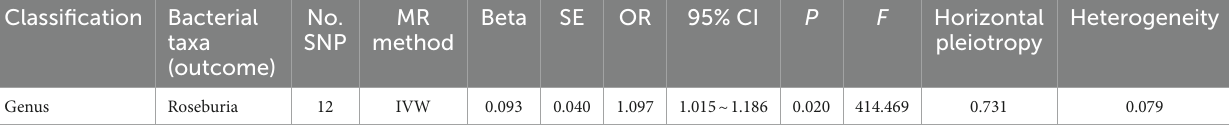
TABLE 5 Reverse MR analysis of ADHD on significant gut microbiota in discovery stage (genome-wide statistical significance Level, p < 5 × 10 − 8 ). Classification Bacterial